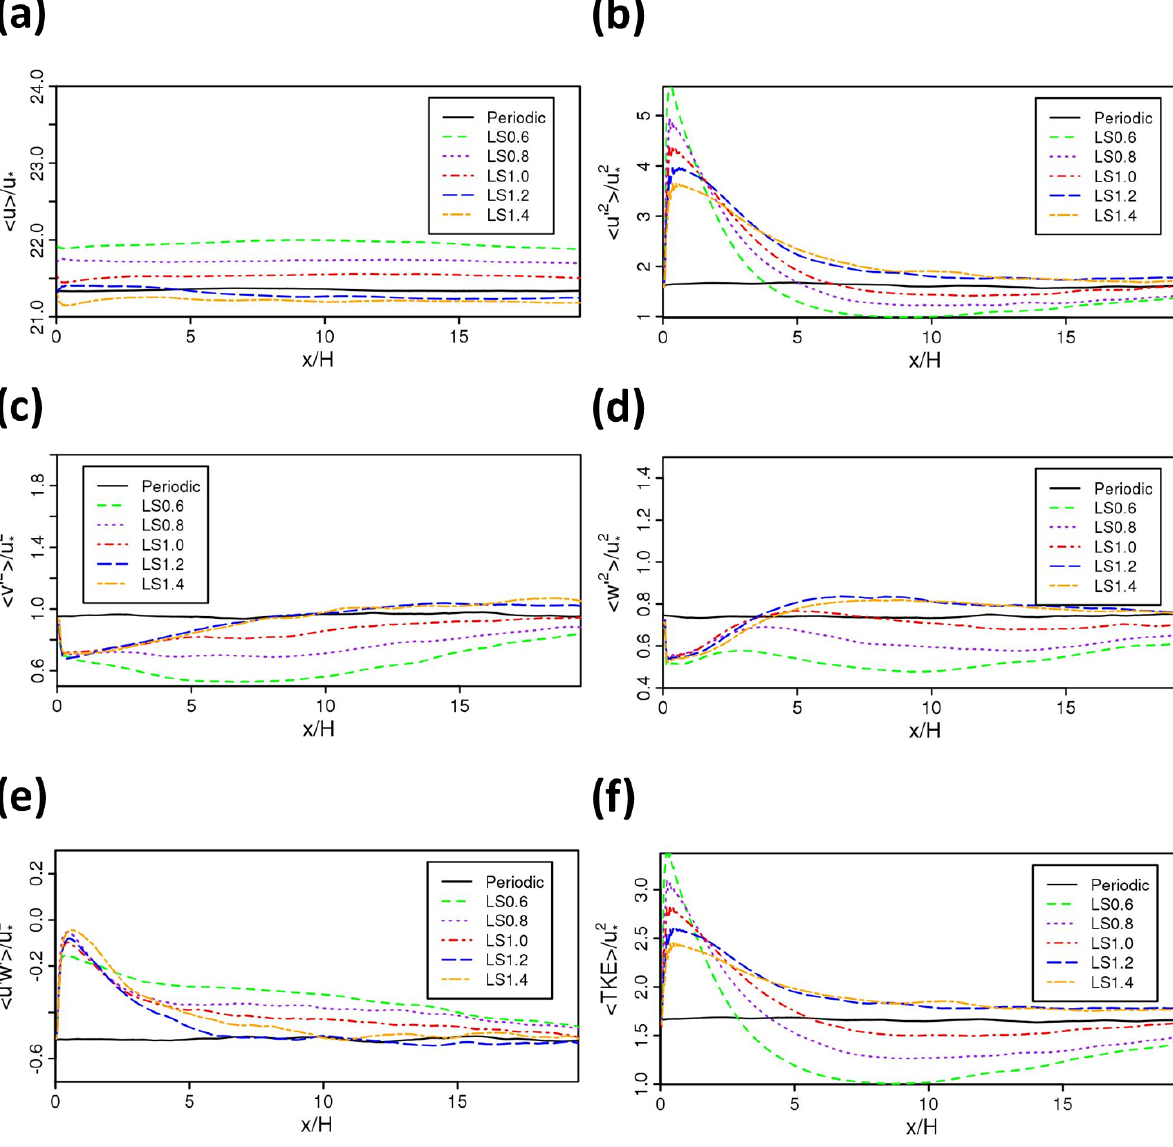
Figure 8. Horizontal profiles (spatially and temporally averaged) of (a) (cid:104) u (cid:105) /u ∗ , (b) (cid:104) u (cid:48) 2 (cid:105) /u 2 ∗ , (c) (cid:104) v (cid:48) 2 (cid:105) /u 2 ∗ , (d) (cid:104) w (cid:48) 2 (cid:105) /u 2 ∗ , (e) (cid:104) u (cid:48) w (cid:48) (cid:105) /u 2 ∗ , and (f) (cid:104) TKE (cid:105) /u 2 ∗ at z/H = 0 . 5 with various integral length